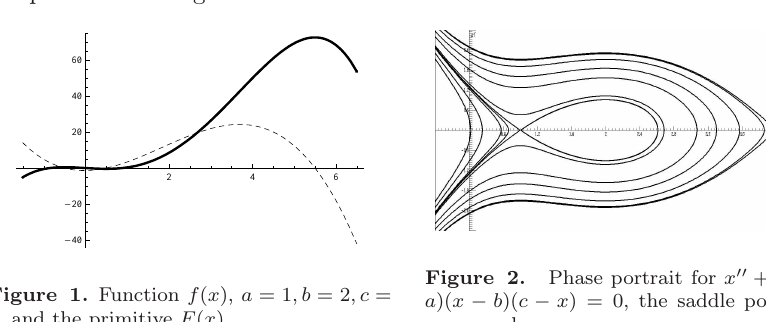
Figure 1. Function f ( x ) , a = 1 ,b = 2 ,c = 7 , and the primitive F ( x ) .